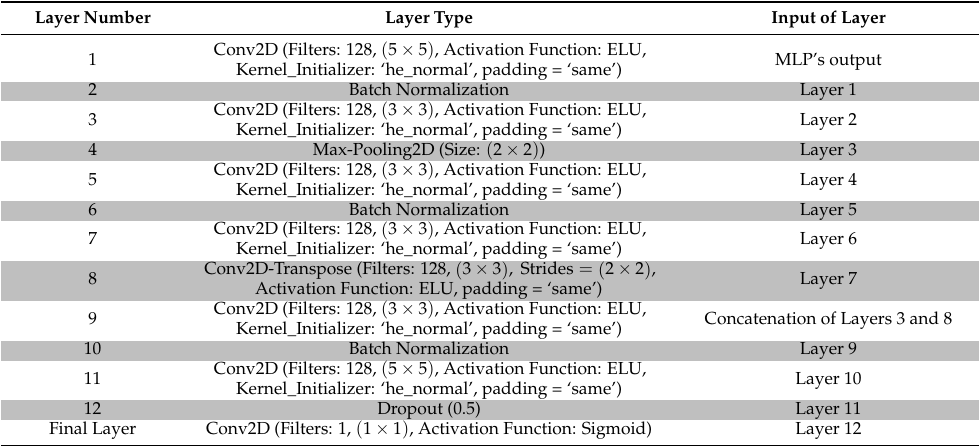
Table 1. The U-Net (spatial sub-model) model’s